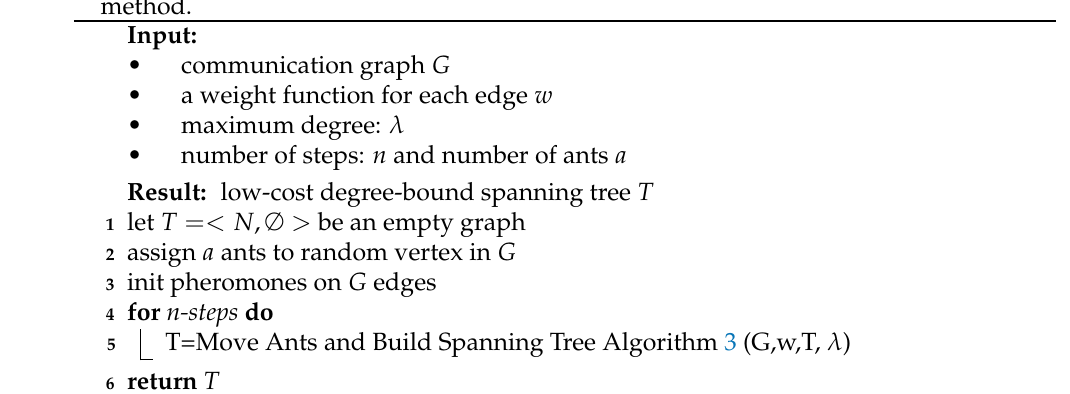
Algorithm 2: AC algorithm for low cost degree-bound spanning tree: Main